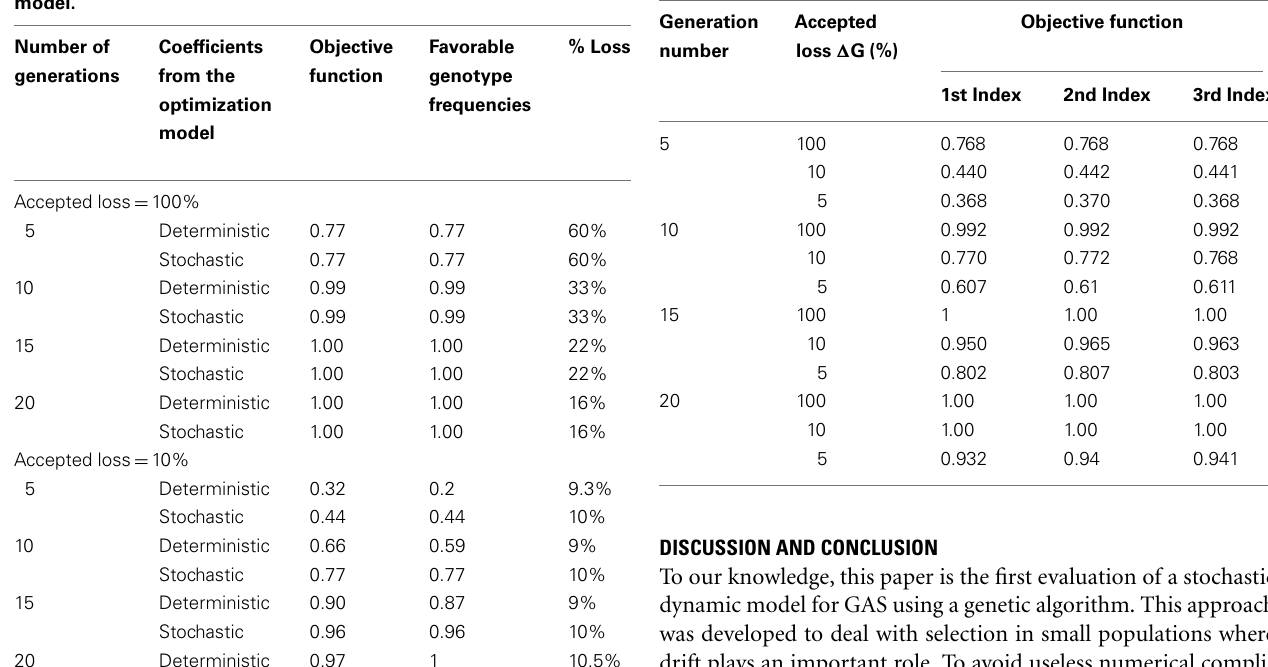
Table 5 | Objective function values obtained with the different indexes for 5, 10, 15, and 20 generations, 5, 10, and 100% of loss of genetic